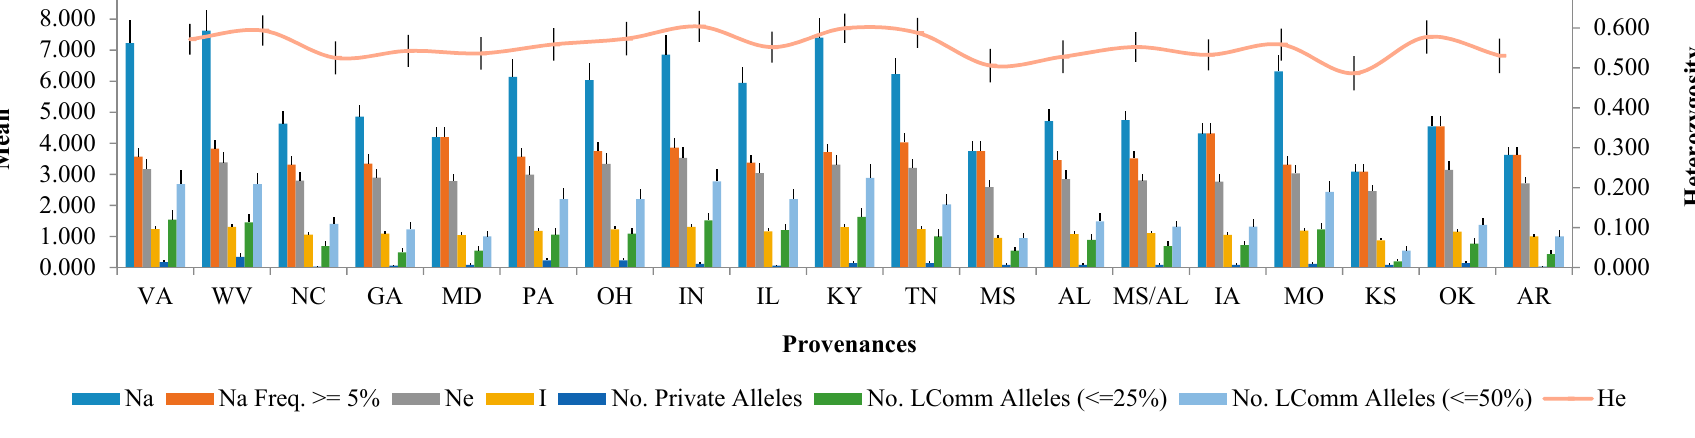
Figure 1. Average genetic diversity indices for the 19 provenances of Robinia pseudoacacia L. analyzed in this study. Na : No. of Different Alleles; Na Freq. ≥ 5%: No. of different alleles with a frequency ≥ 5%; Ne : No. of effective alleles = 1/(Sum pi 2 ); I : Shannon’s Information Index, I = − 1 Sum (pi Ln (pi)); No. Private Alleles: No. of alleles unique to a single provenance; No. LComm Alleles ( ≤ 25%): No. of locally common alleles (Freq. ≥ 5%) found in 25% or fewer provenances; No. Lcomm Alleles ( ≤ 50%): No. of locally common alleles (Freq. ≥ 5%) Found in 50% or fewer provenances; He : Expected heterozygosity, He = 1 − Sum pi 2 . The error line in each column is the standard error values of corresponding diversity index.